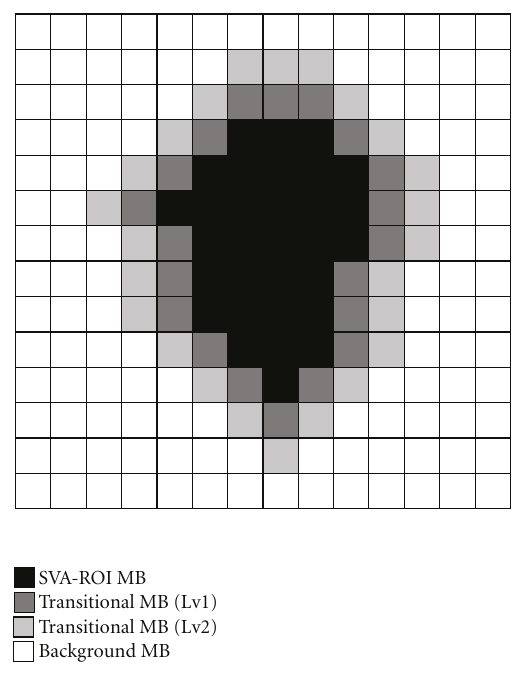
Figure 3: Sample of attention